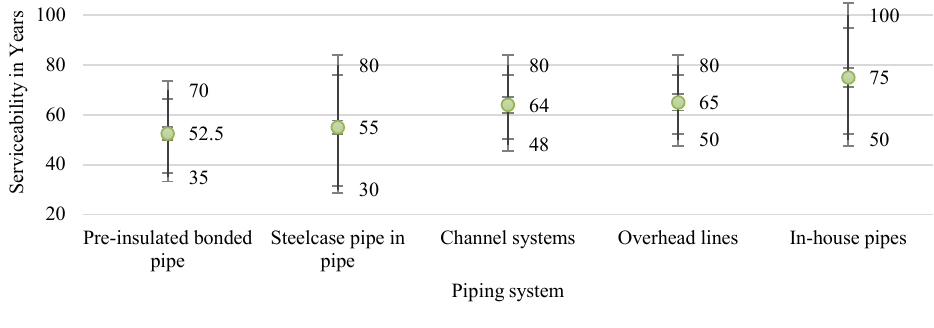
Fig. 1. Expected technical service life of piping systems according to AGFW, FW114